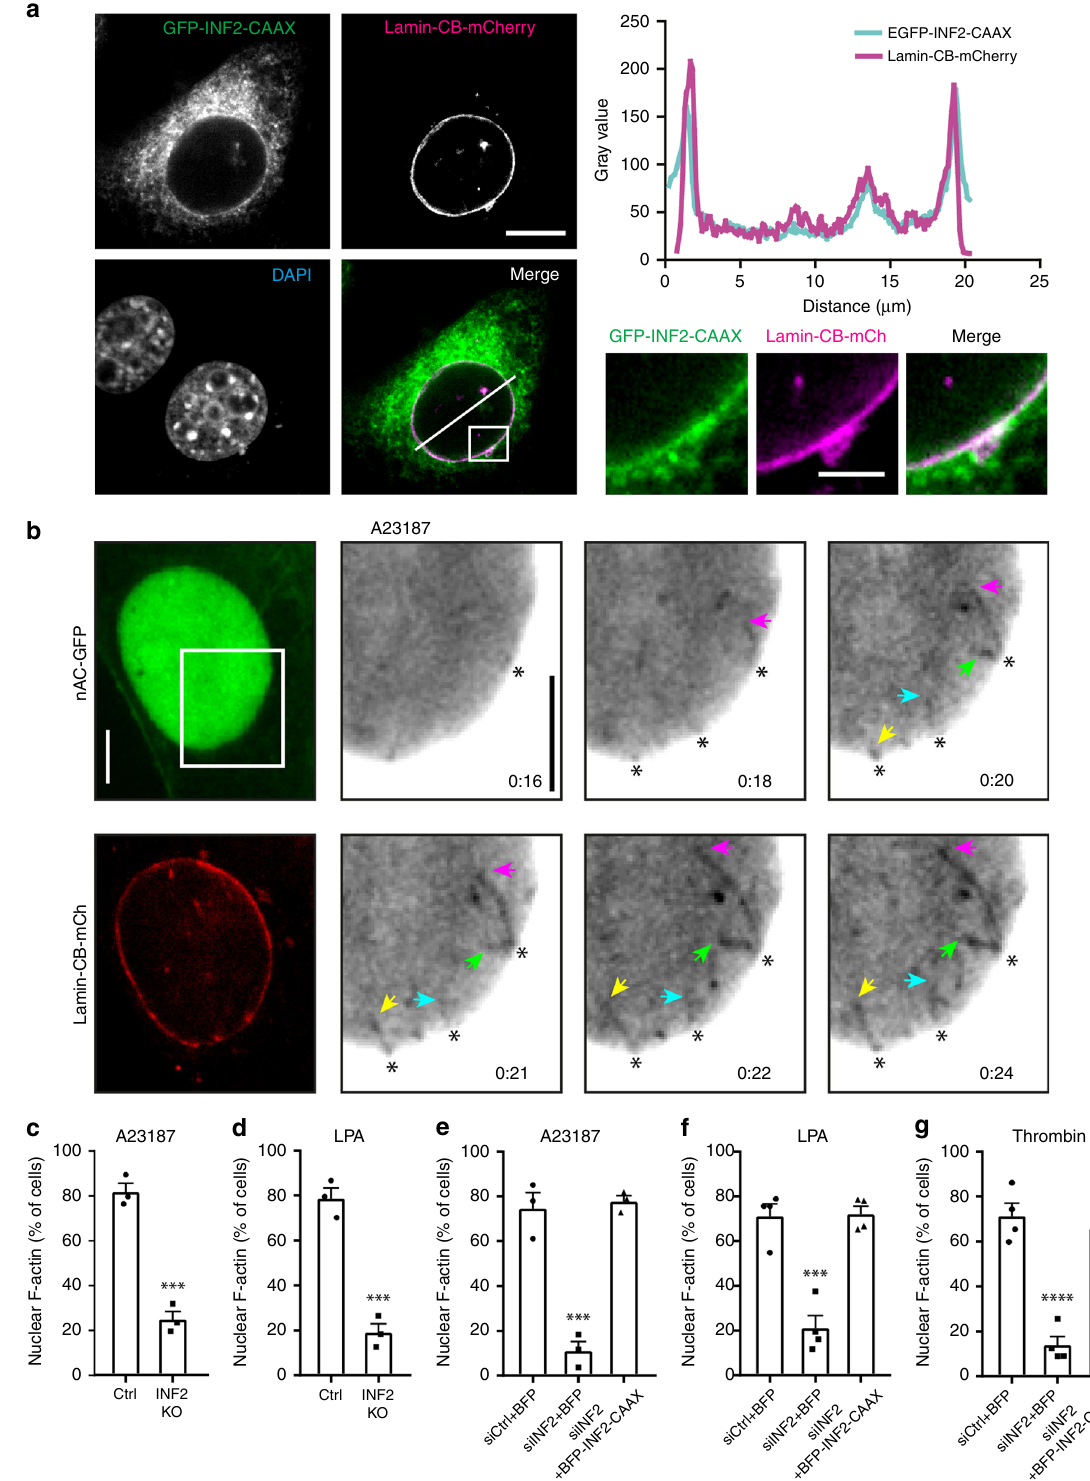
Fig. 3 Calcium-induced nuclear F-actin depends on INF2. a NIH3T3 cells were transfected with GFP-INF2-CAAX and Lamin-Chromobody (CB)-mCherry and fi xed (scale bar: 10 μ m). Images from one representative cell out of 18 cells are enlarged (scale bar: 3 μ m), and gray value plot was drawn showing colocalization of INF2 and Lamin A/C on the nuclear envelope. b NIH3T3 cells stably expressing nAC-GFP were transfected with Lamin-CB-mCherry and stimulated by A23187 to visualize nuclear F-actin polymerization. Arrowheads show the tips of actin fi laments originating from nuclear envelope. Scale bar: 5 μ m. c , d INF2 was knocked out (INF2 KO) by CRISPR/Cas9 genome editing in NIH3T3 cells stably expressing nAC-GFP. Both control and knockout cells were stimulated with A23187 or LPA. n = 3 independent experiments. Two-sided Student's t test, *** p ≤ 0.001. e – g INF2-silenced cells were rescued by BFP-INF2-CAAX isoform after A23187 ( n = 3), LPA ( n = 4) or thrombin ( n = 4) treatment. Both control and INF2 siRNAs are modi fi ed on the sense strand with 3 ’ -AlexaFluor 647. INF2 siRNA targets the 3 ’ -UTR. One-way ANOVA test, *** p ≤ 0.001, **** p ≤ 0.0001. Error bars: + s.e.m. Source data are provided as a Source Data fi